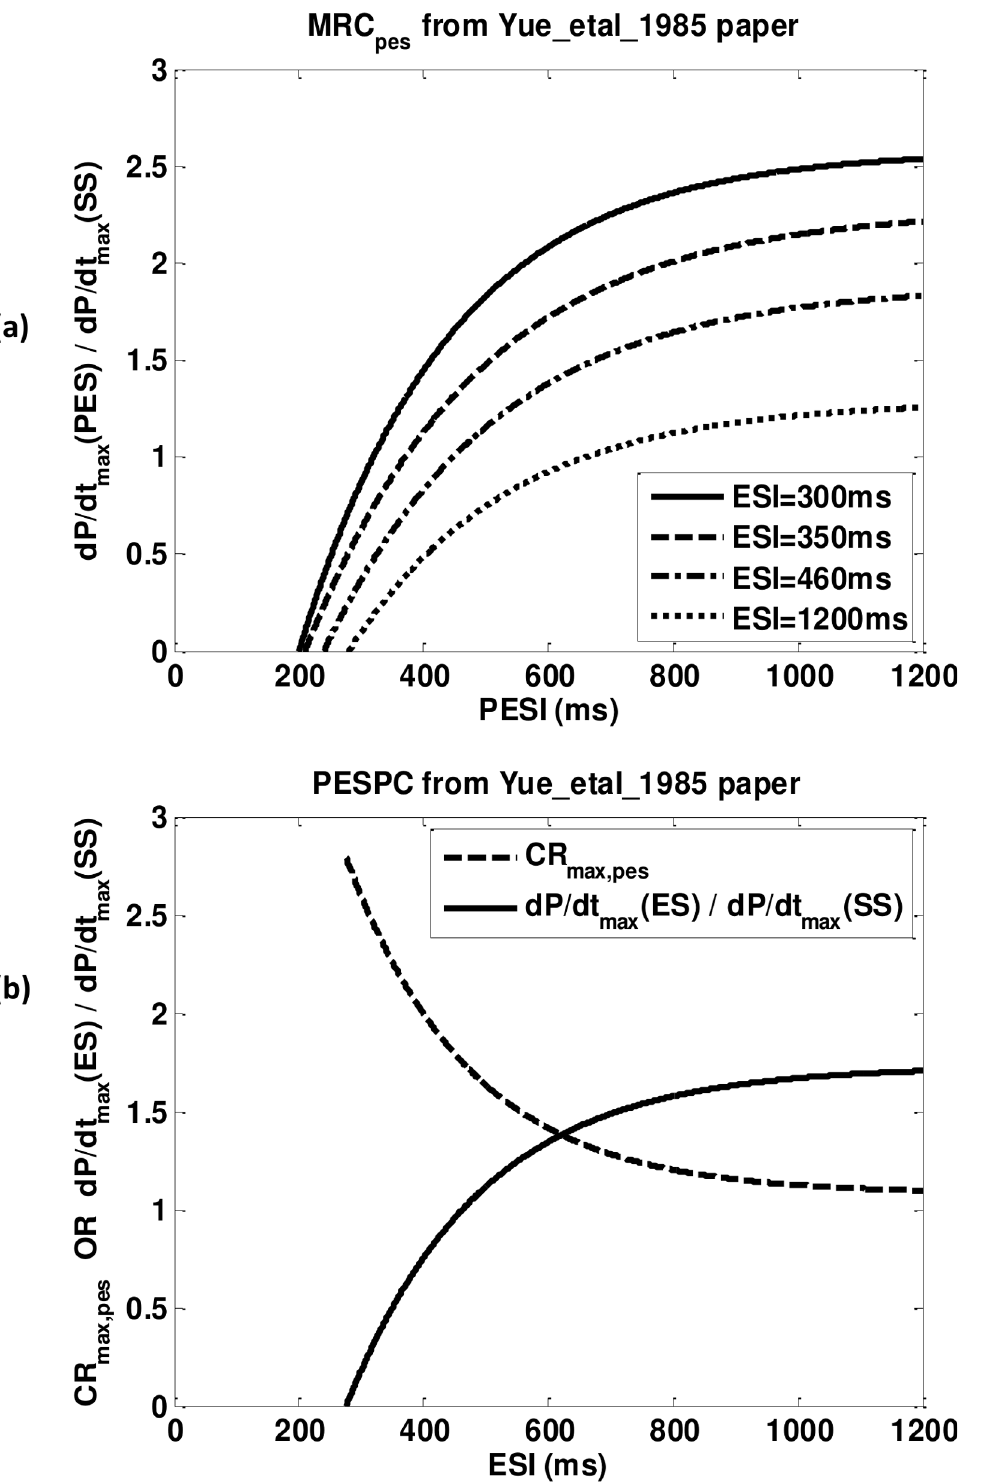
Fig 1. Contractile characteristic curves generated from equations in Yue experiments. (a) Postextrasystolic mechanical restitution curves ( MRC pes ) using ESI equal to 300ms (solid line), 350ms (dash line), 460ms (dash-dot line) and 1200ms (dot line). (b) Postextrasystolic potnetiation curve (PESPC, dash line) and extrasystolic mechanical restitution curve ( MRC es , solid